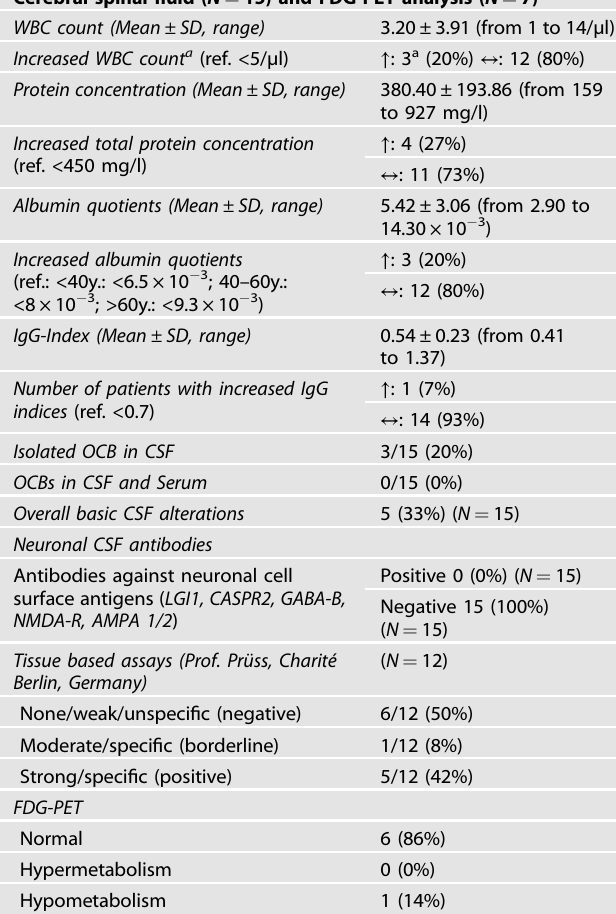
Table 5. Additional analyses in a subgroup of patients. Cerebral spinal fl uid ( N = 15) and FDG-PET analysis ( N =